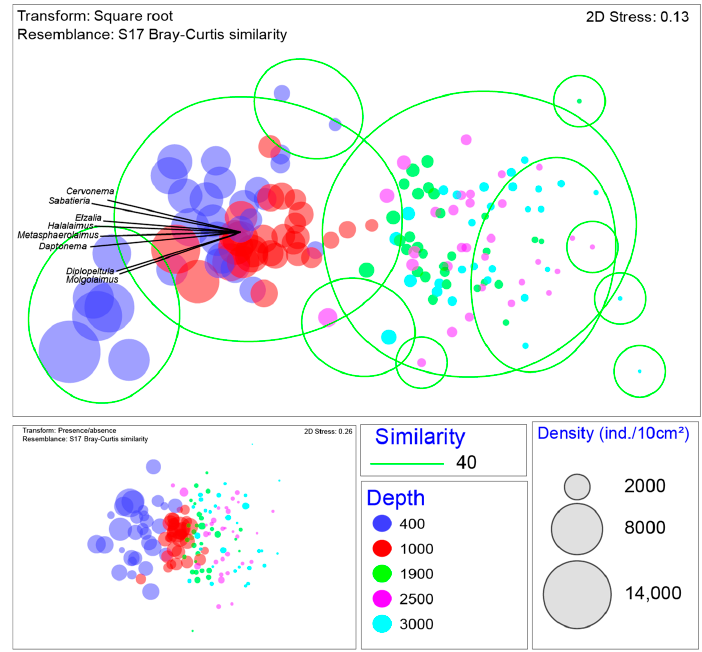
Figure 4. nMDS (non-metric multidimensional scaling) based on nematode community structure indicating clear separation between the upper slope (400, 1000 m) and lower slope (1900, 2500, 3000 m) stations. Bubble sizes suggest distinct communities according to density of the nematode genera, but presence–absence transformation (removal of density influence) supports the same upper–lower slope contrast in community structure (lower left insert) based on distinct nematode genera assemblage differences.